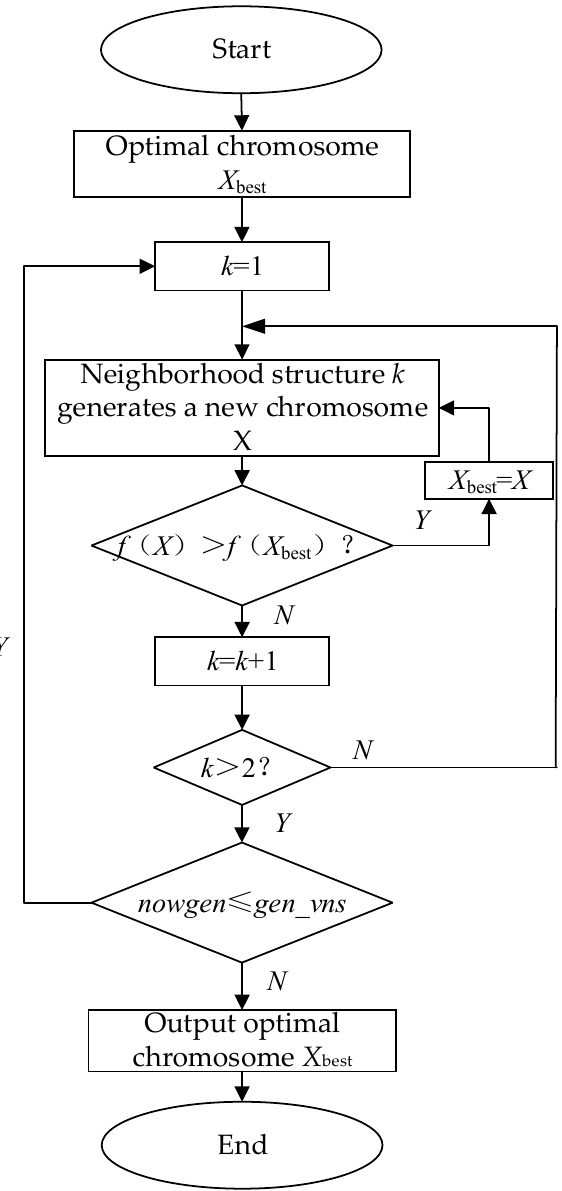
Figure 6. Small-scale neighborhood structure process.